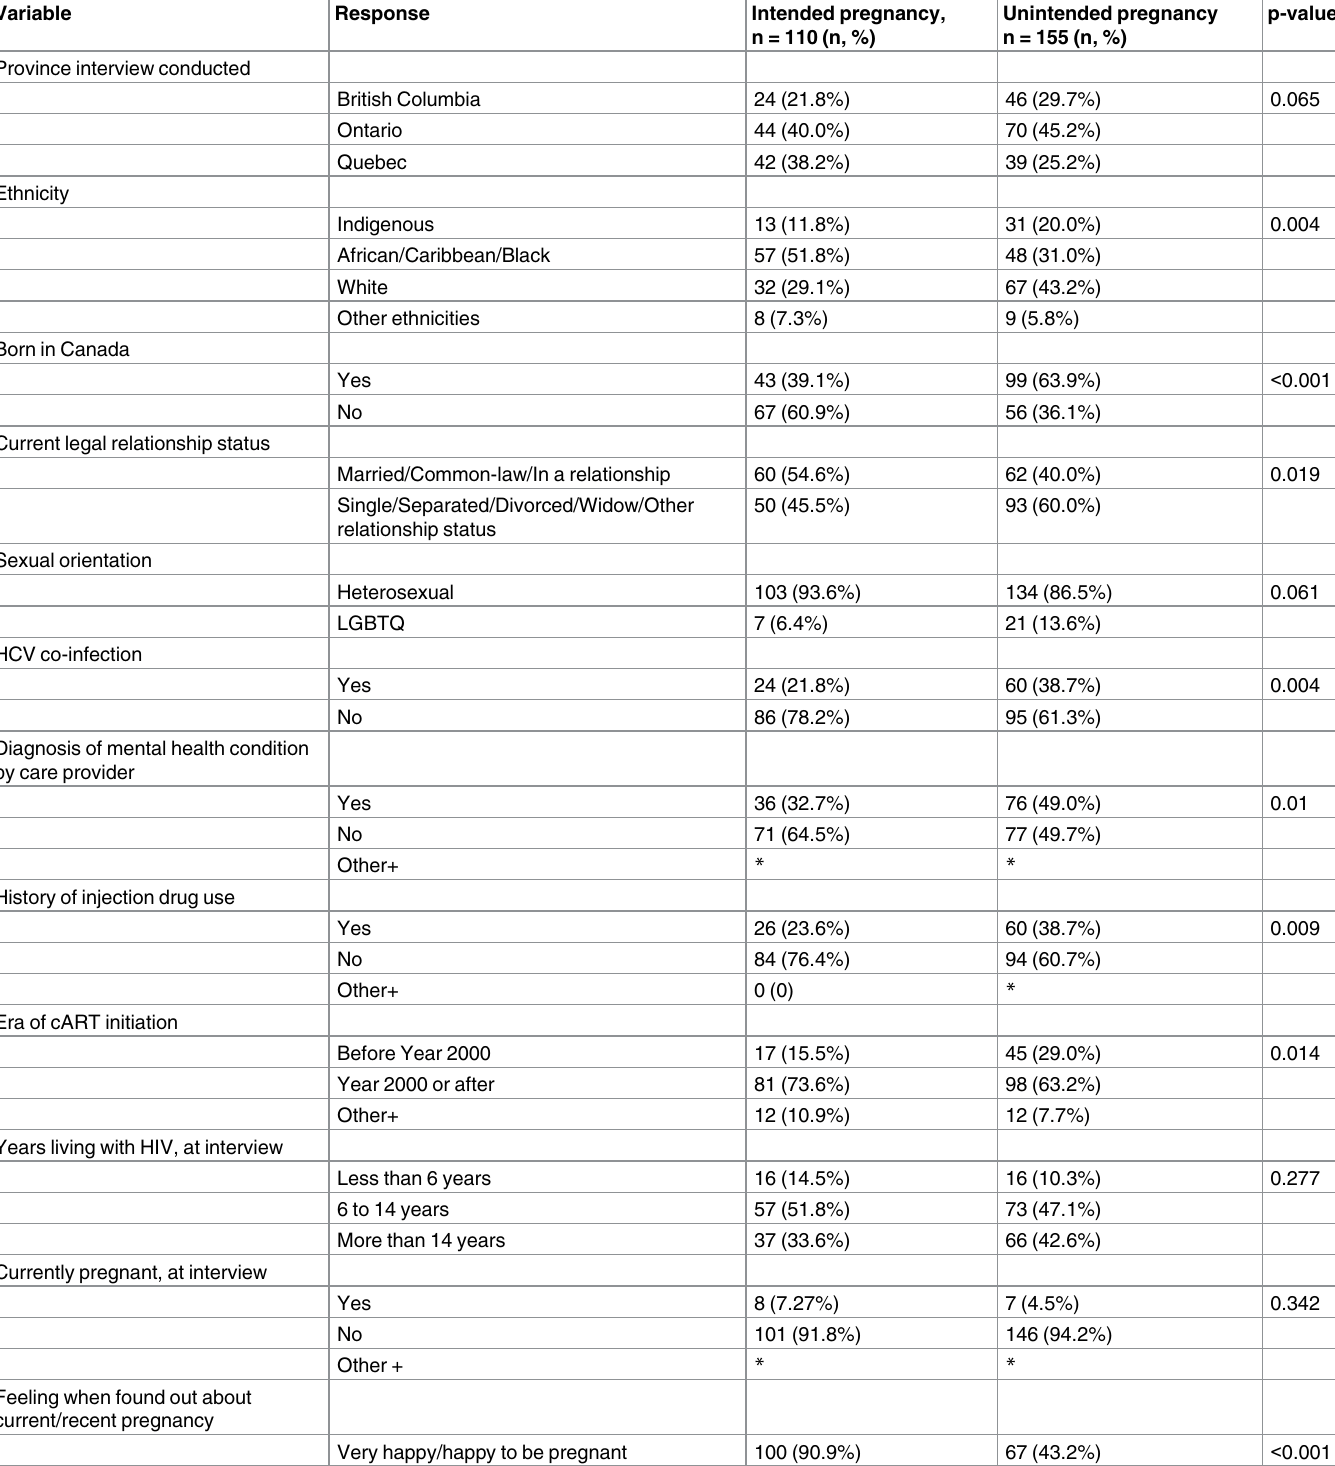
Table 3. Bivariate analysis for intended vs. unintended current or most recent pregnancy, among women living with HIV (n =